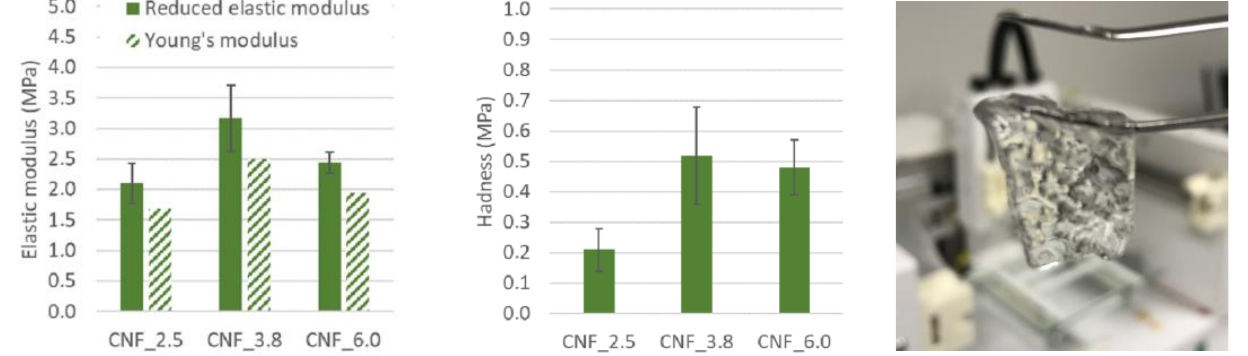
Figure 6. Nano-mechanical properties of CNF hydrogels (0.6 wt.%). ( Left ) Reduced and Young’s modulus. ( Middle ) Hardness. ( Right ) Example of a 3D-printed specimen cross-linked with CaCl 2 .